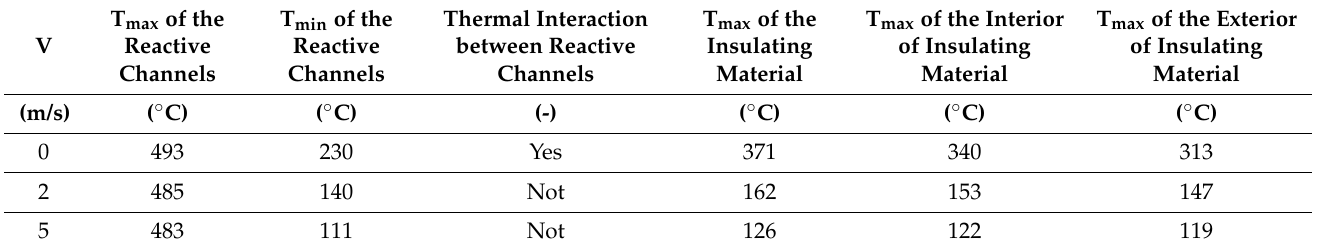
Table 3. A summary of the most relevant simulation data obtained for the multi-tubular fixed-bed geometry configured with a total of ten reactive channels under a circular-shaped